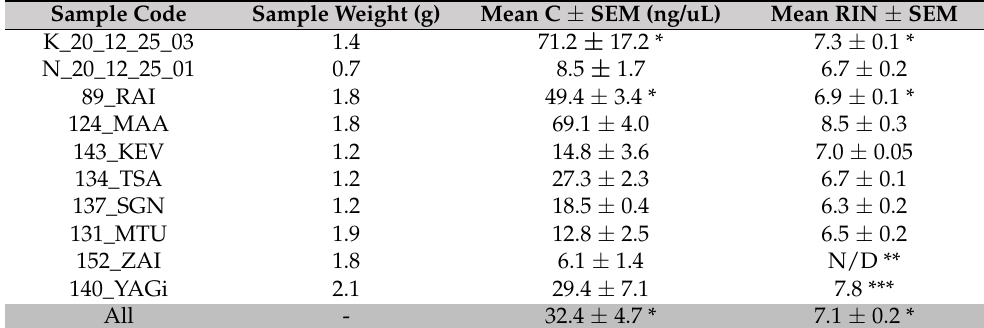
Table 3. Mean concentrations and